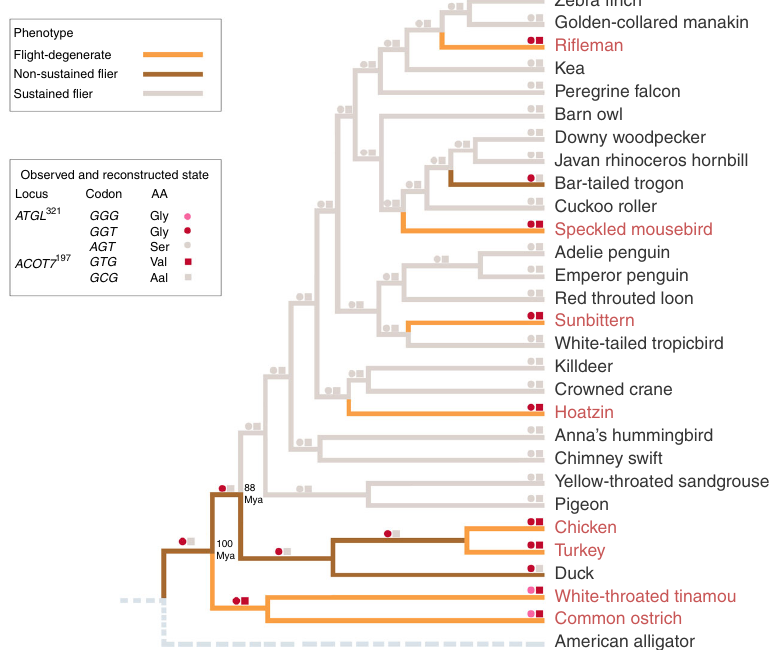
Fig. 6 Ancestral state reconstruction for ATGL 321 and ACOT7 197 codons. The avian phylogeny from the previous study 5 that we contributed to was used with the American alligator genome used as the